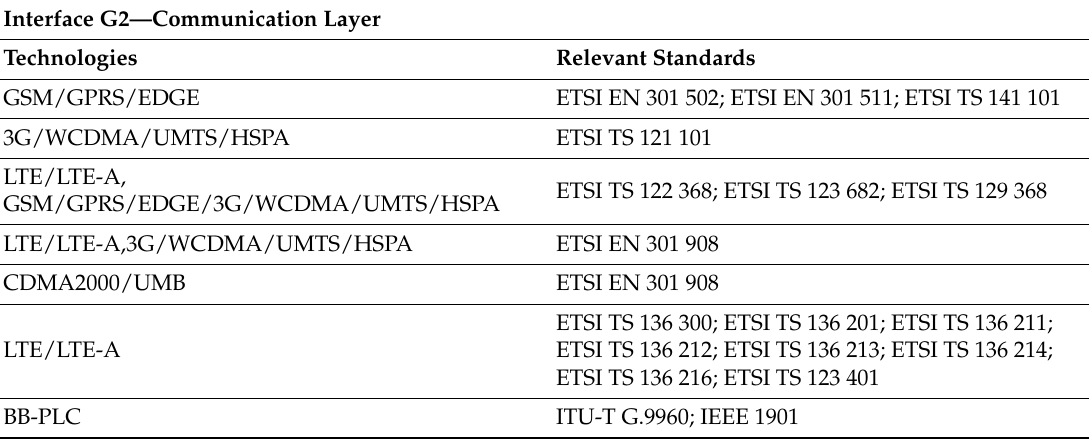
Table 4. Interface G2 and standards for the communication layer.